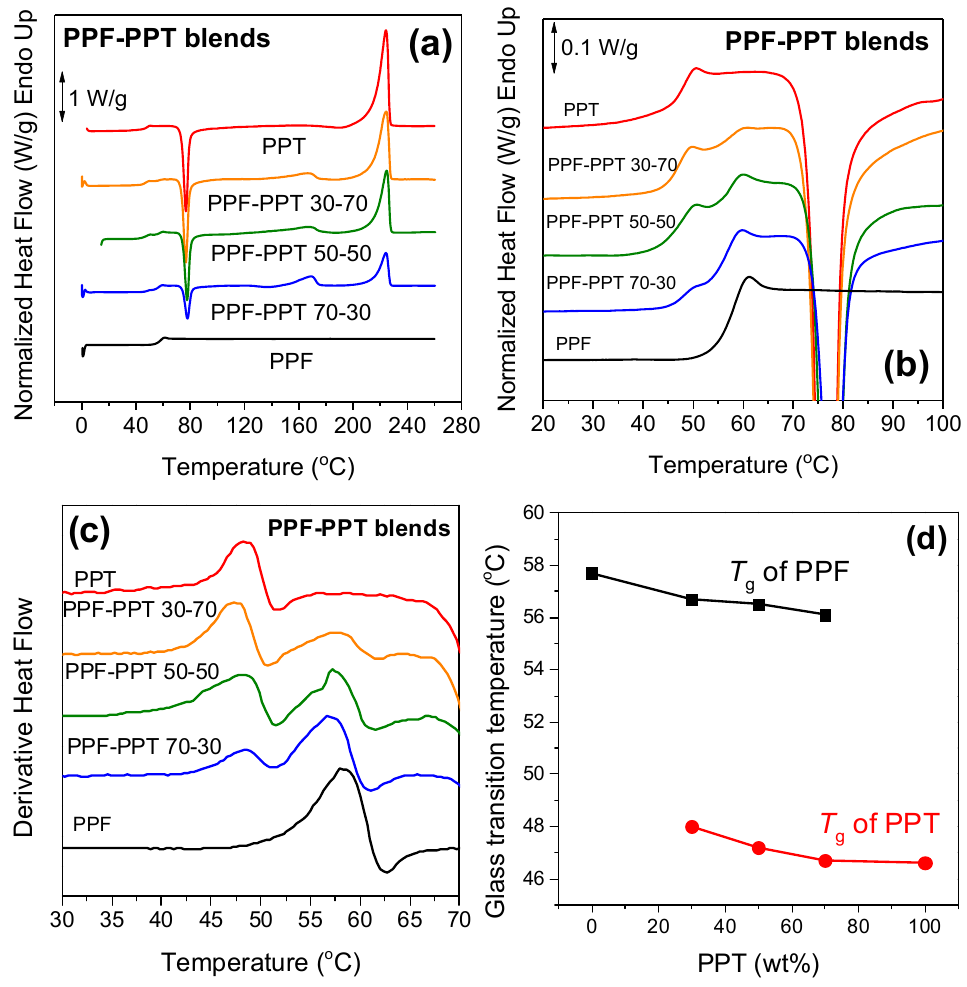
Figure 5. ( a ) DSC thermograms of PPF, PPT, and their blends, ( b ) zoomed-in area of the glass temperature, ( c ) derivative of heat flow of the samples under study, and ( d ) the variation of T g with PPT content.